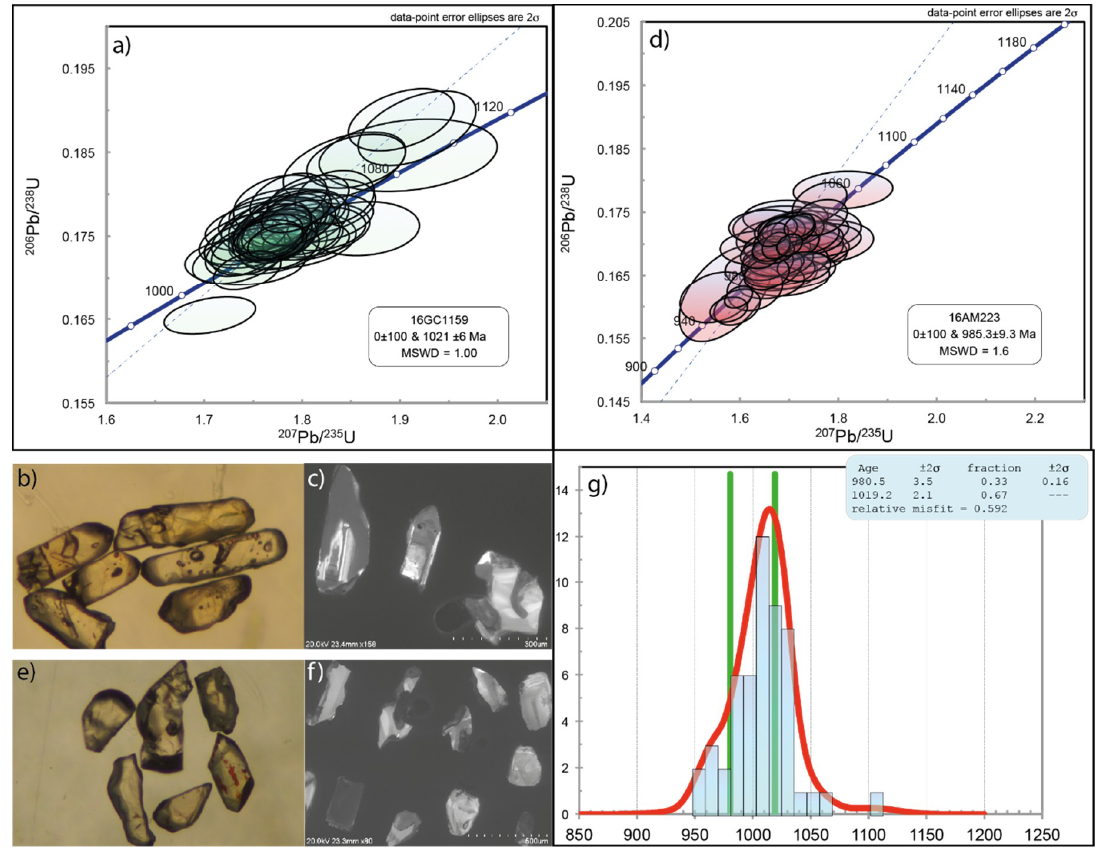
Figure 6. Zircon and Concordia diagram ( a ) Concordia diagram from the zircon of the Wemotaci Intrusive, ( b ) Zircon from the Wemotaci Intrusive Suite, ( c ) CL image for the zircon of the Wemotaci Intrusive Suite, ( d ) Concordia diagram for the zircon of the Rheaume Intrusive Suite, ( e ) Zircon from the Rheaume intrusive suite, ( f ) The CL images for the zircon from the Rheaume Intrusive Suite, ( g ) Statistical deconvolution modeling the results from the zircon of the Rheaume Intrusive Suite.